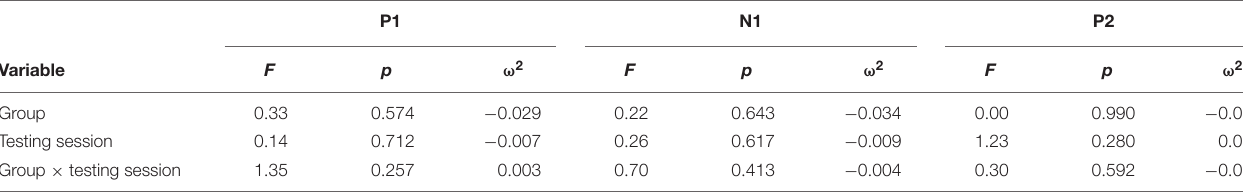
TABLE 9 | Results of P1-N1-P2 latencies at FCz repeated measures